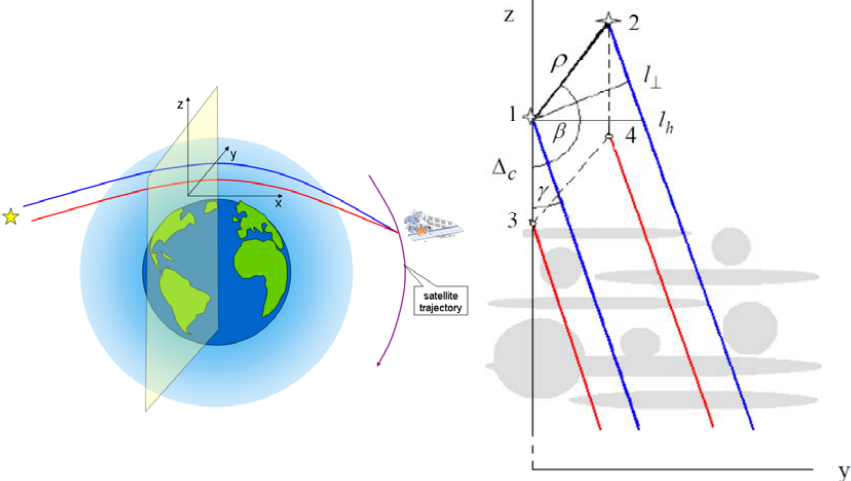
Fig. 1. Left panel: illustration of occultation geometry. Yellow plane represents the phase screen. Blue and red lines denote colored ray trajectories for a single star, which are recorded simultaneously by the instrument. Right panel: a sketch of ray trajectories of binaries in the phase screen during occultations. The points 1-4, which are located in a vertices of a parallelogram, are the points of intersection of light rays with the phase screen (1-2 for the blue photometer and 3-4 for the red photometer). ∆ is the chromatic shift, i.e. the vertical distance between red and blue rays (1-3 for the first component of a double star, 2-4 are for the second component). Atmospheric irregularities are schematically shown by gray circles and ellipses. Anisotropic irregularities are oblate spheroids with horizontal isotropy and small axis along the vertical.